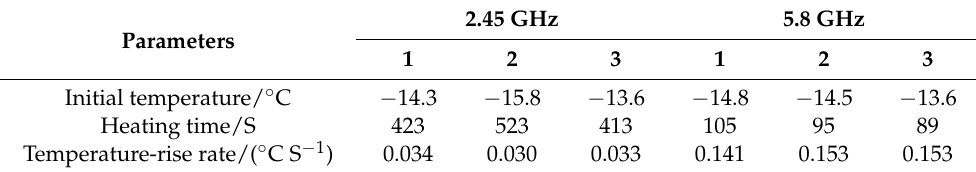
Table 7. Efficiency of asphalt concrete under different microwave frequencies.